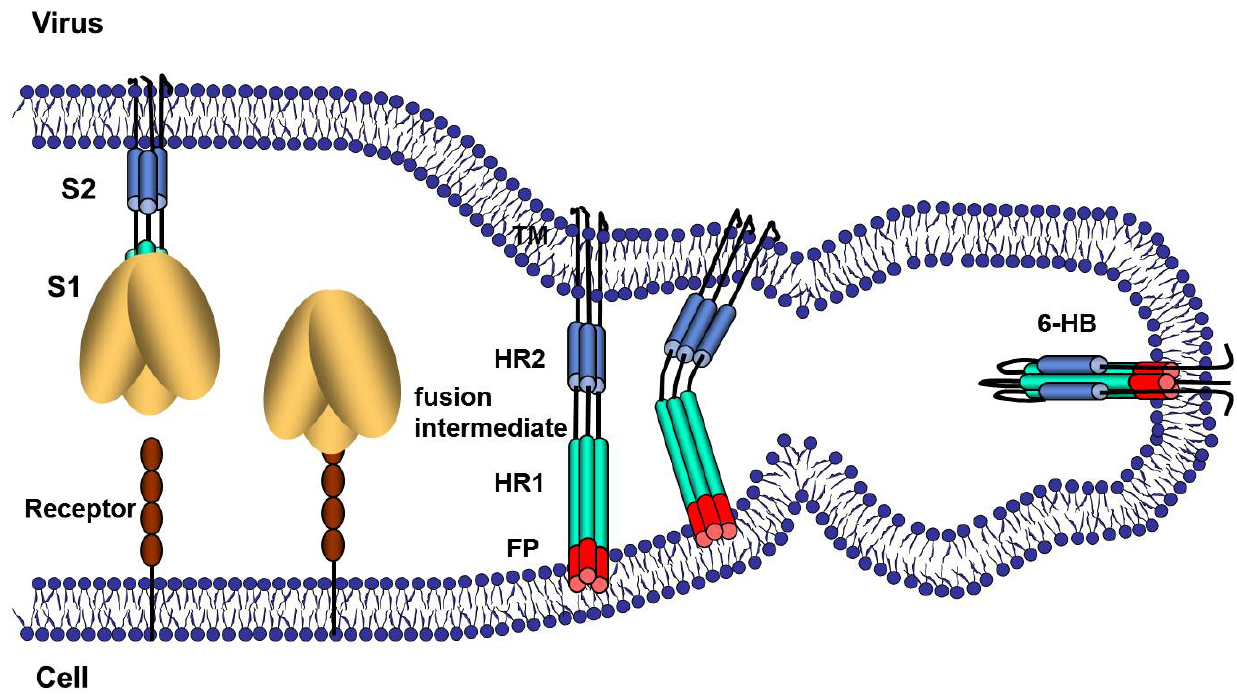
Figure 2. Schematic illustration of CoV S protein-mediated membrane fusion. The illustrations represent several steps of S protein conformational changes that may take place during membrane fusion. In the first step, receptor binding, pH reduction and/or S protein proteolysis induces dissociation of S1 from S2. This step is documented for some MHVs [29,30]. In the second step, the fusion peptide (FP) is intercalated into the host cell membrane. This is the fusion-intermediate stage. In the third stage, the part of the S protein nearest to the virus membrane refolds onto a heptad repeat 1 (HR1) core to form the six-helix bundle (6-HB), which is the final postfusion configuration of the S2